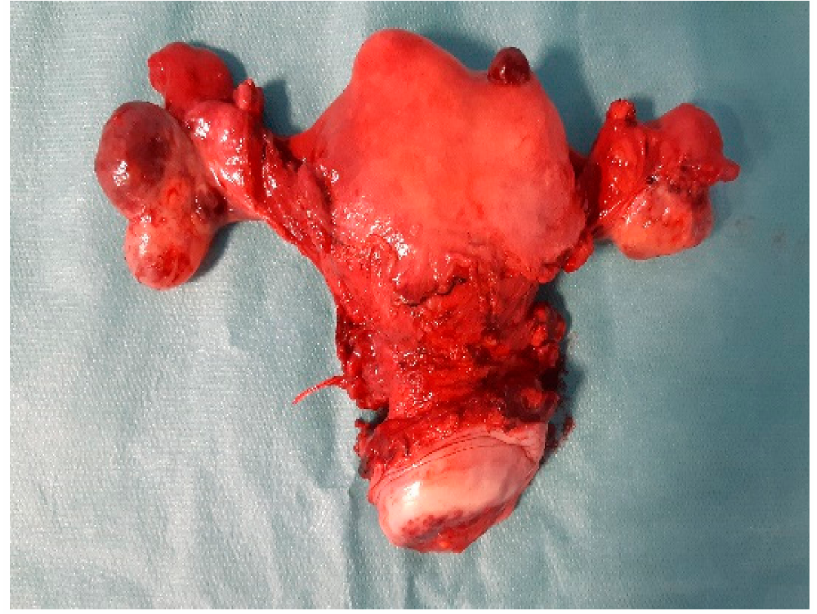
Figure 2. Operative image: Macroscopic examination of the uterine tumors with extension on the left